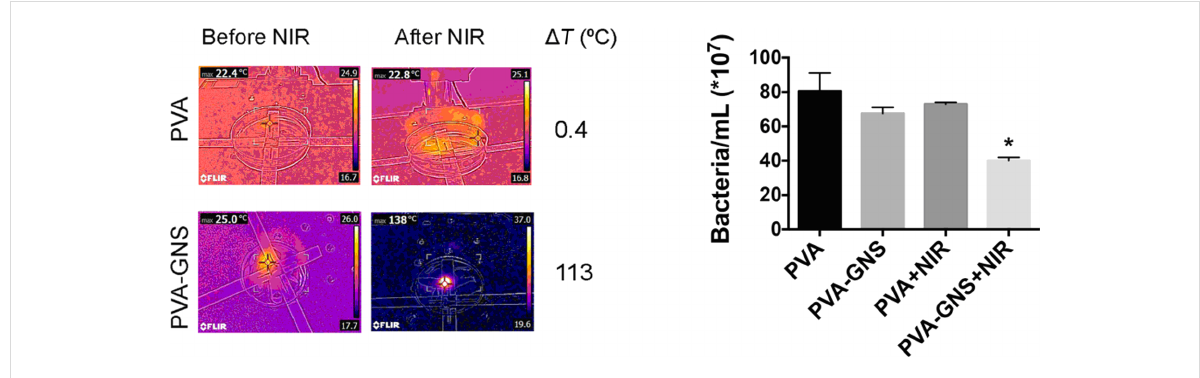
Figure 4: Left panel: temperature increase upon 1064 nm laser irradiation of bare PVA films and PVA films containing gold nanostars (GNSs). Right panel: Bacteria ablation on PVA/gold nanostar films as result of the NIR-induced photothermal effect. Figure reprinted with permission from [66],